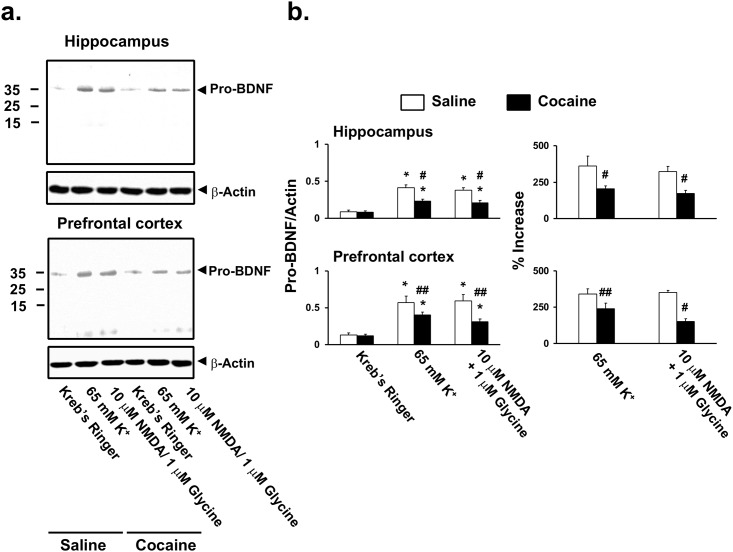
Prenatal cocaine exposure reduced proBDNF release in hippocampi (top) and PFCX (bottom).Brain slices treated with 10 μM of MMP-9 inhibitor I and tPA inhibitor were used to assess proBDNF released spontaneously and induced by 10-min 10 μM NMDA/1 μM glycine or 1-min 65 mM K+-depolarization. ProBDNF in the perfusate were then immunoprecipitated with immobilized anti-BDNF and the level of proBDNF was determined by Western blotting with specific anti-proBDNF. The brain slices were collected, homogenized, and solubilized and the level of β-actin in the brain slices was determined by Western blotting. The blots were quantified by densitometric scanning. Data are means ± s.e.m. of the ratios of proBDNF optical intensity to the optical intensity of β-actin that serves to verify equal amounts of tissues. n = 5 (3 males and 2 females). **p < 0.05, *p < 0.01 compared to LMKR-treated in the same group. ##p < 0.05, #p < 0.01 compared to respective protein in the saline-treated group.